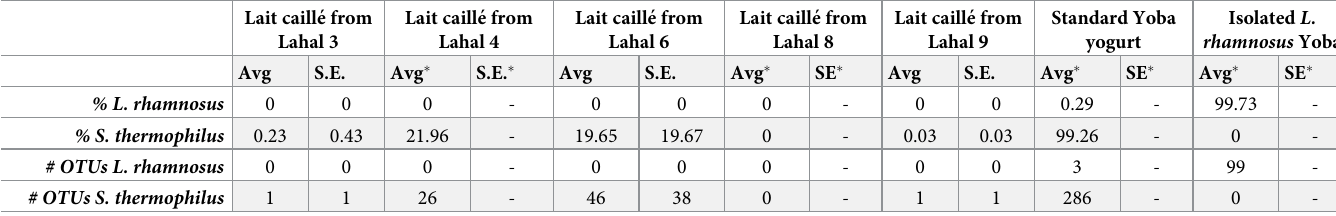
Percentages and total numbers of OTUs found in lait caille´ before the addition of Yoba starter culture, standard Yoba yogurt, and Lactobacillus rhamnosus Yoba isolated from the standard Yoba yogurt that blasts as L . rhamnosus or S . thermophilus . � values based on one